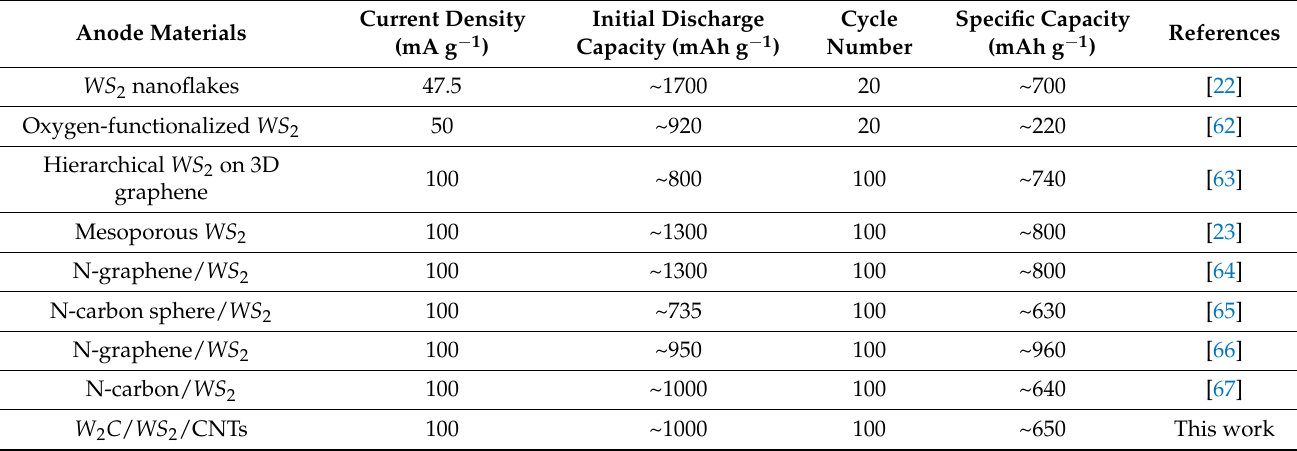
Table 1. Comparison of electrochemical performance of WS 2 -based composite materials for lithium-ion